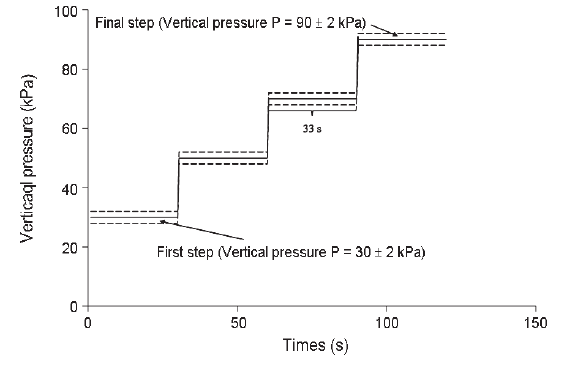
Fig. 4. Experimental